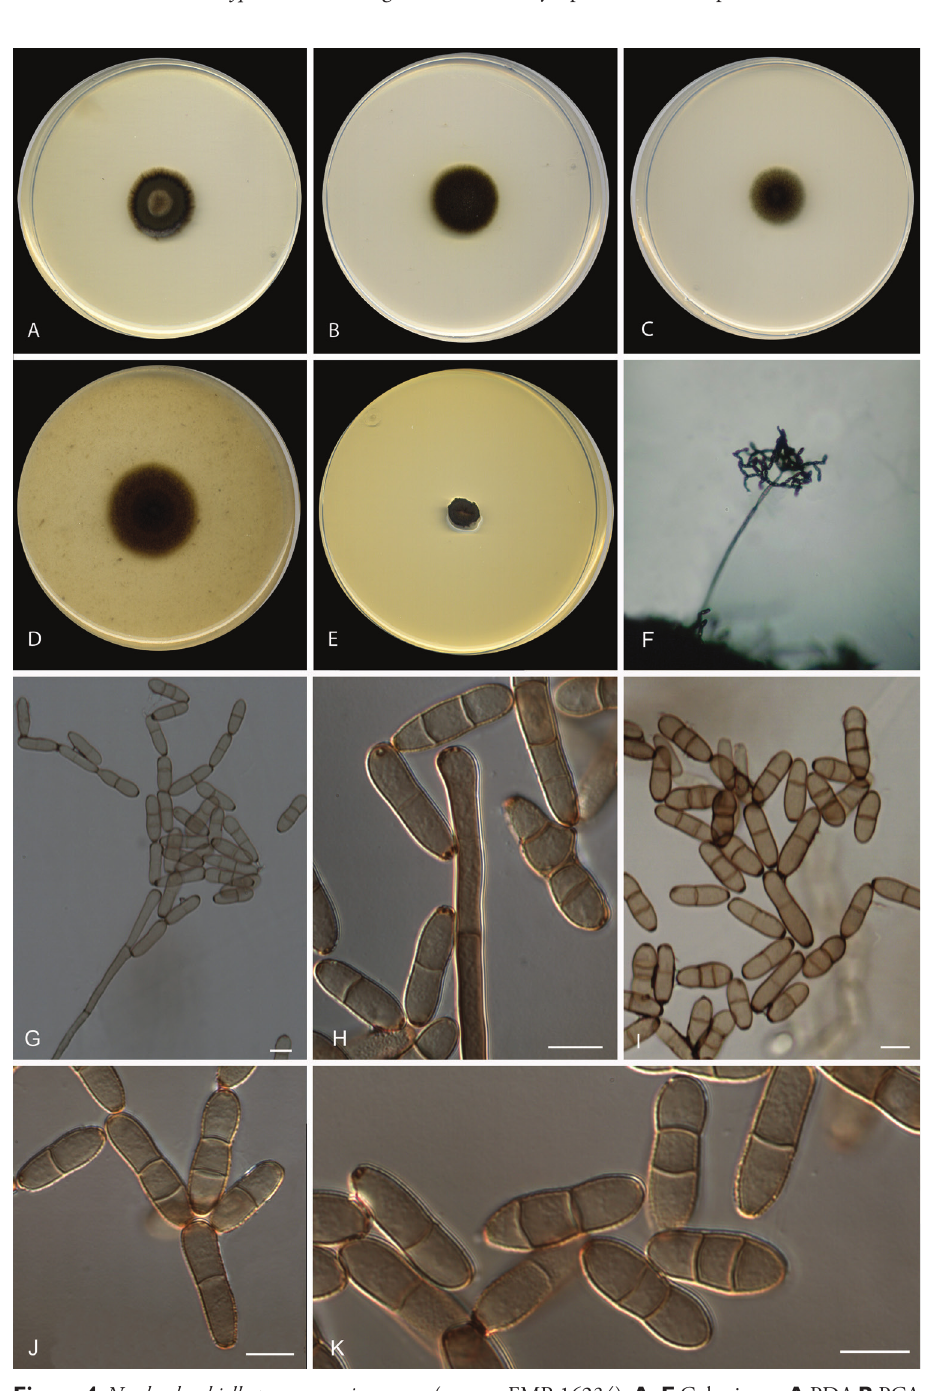
Figure 4. Neodendryphiella tarraconensis sp. nov. (ex-type FMR 16234). A–E Colonies on A PDA B PCA C SNA D OA E MEA at 25 °C after 14 d F–K Conidiophores and conidia. Scale bars:10 μm ( G–K